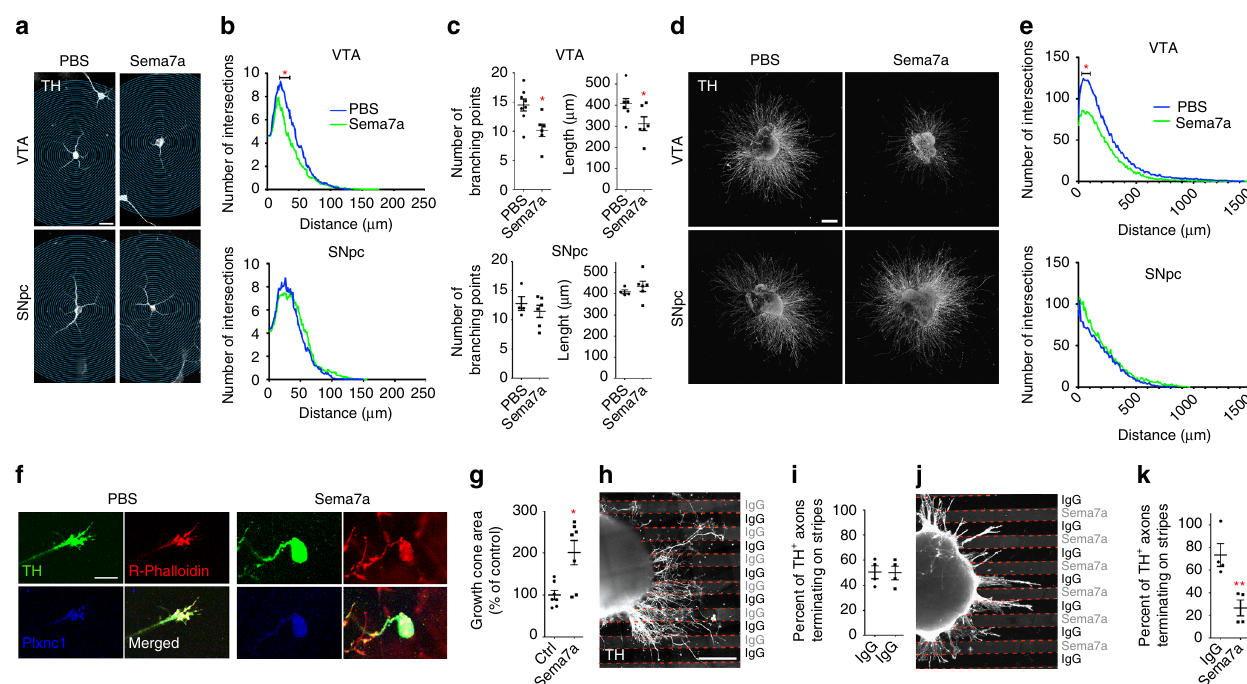
Fig. 6 In vitro experiments showing the effect of Sema7a on VTA and SNpc neurons. a , c Sholl analysis on ventral midbrain primary VTA or SNpc neuron cultures exposed to PBS or Sema7a. a Examples of confocal images of VTA and SNpc neurons with their respective Sholl intersection circle mask. b , c Quantitative analysis of the VTA and SNpc neurite intersection pro fi les, number of branches, and neurite length (SNpc: 71 neurons analyzed from 5 independent cultures; VTA: 114 neurons analyzed from 7 independent cultures; b : two-way ANOVA, and the Sidak test was used for post hoc comparisons, * p < 0.05; c : two-tailed unpaired t test, p (VTA Branch) = 0.0137, p (VTA length) = 0.0335, p (SNpc Branch) = 0.4370, p (SNpc length) = 0.4395). d Examples of embryonic ventral midbrain explants from E14.5 Pitx3-GFP embryos grown in collagen matrix then exposed to PBS (control) or Sema7a. e Sholl analysis of the neurite intersection pro fi les for the VTA and SNpc explants exposed to PBS or Sema7a (a total of 34 explants from 8 independent cultures, 20 explants from VTA and 14 from SNpc; two-way ANOVA, and the Sidak test was used for post hoc comparisons, * p < 0.05). f Confocal images of growth cones from VTA explants exposed to Sema7a or PBS. g Growth cone size measurements expressed as a percentage of control ( n = 7 independent cultures; 65 growth cones for Sema7a and control were used in each of the 7 experiments, Mann – Whitney U , p = 0.0175). h – k Confocal images of stripe assay and quanti fi cation of the number of axons terminating on stripes for VTA explants grown on the control alternating IgG stripes and the Sema7a stripes alternating with IgG stripes. Dotted lines delineate the stripes ( i , n = 29 explants in 4 independent experiments, two-tailed unpaired t test, p = 0.9349; k , n = 27 explants in 4 independent experiments, two-tailed unpaired t test, p = 0.0091). Scale bars: a , 20 µ m; d , f , h , 250 µ m; j , 10 µ